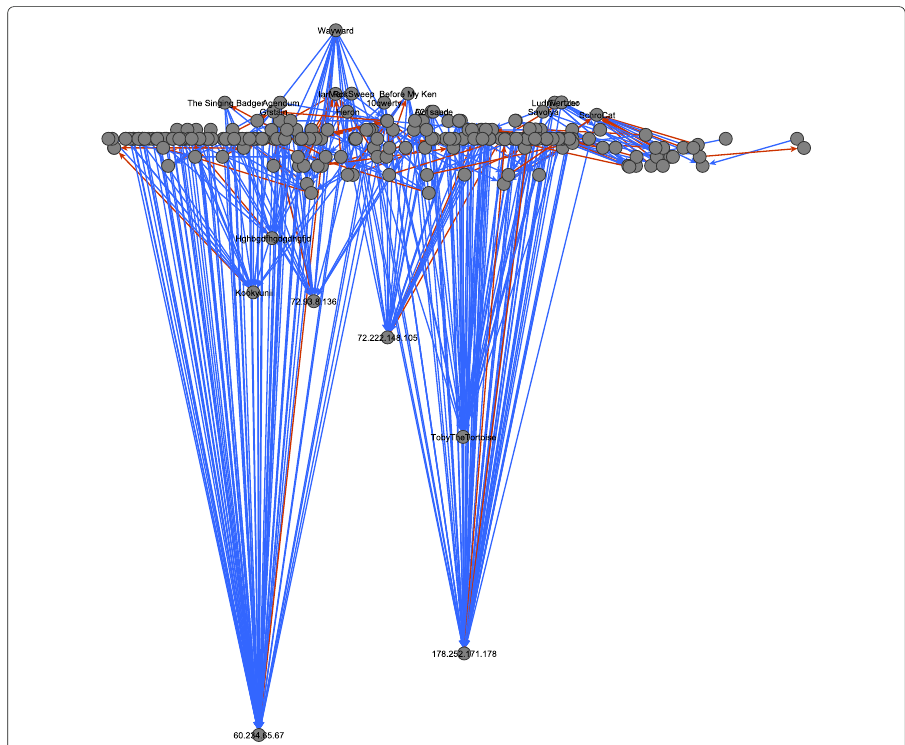
Fig. 6 Hierarchy derived from third-party edits among editors of the Wikipedia article “The Third Man.” The y -coordinate of node A is proportional to the value hierarchy . tpe ( A ) . Dominance edges pointing in the wrong direction (i.e., from lower to higher) are